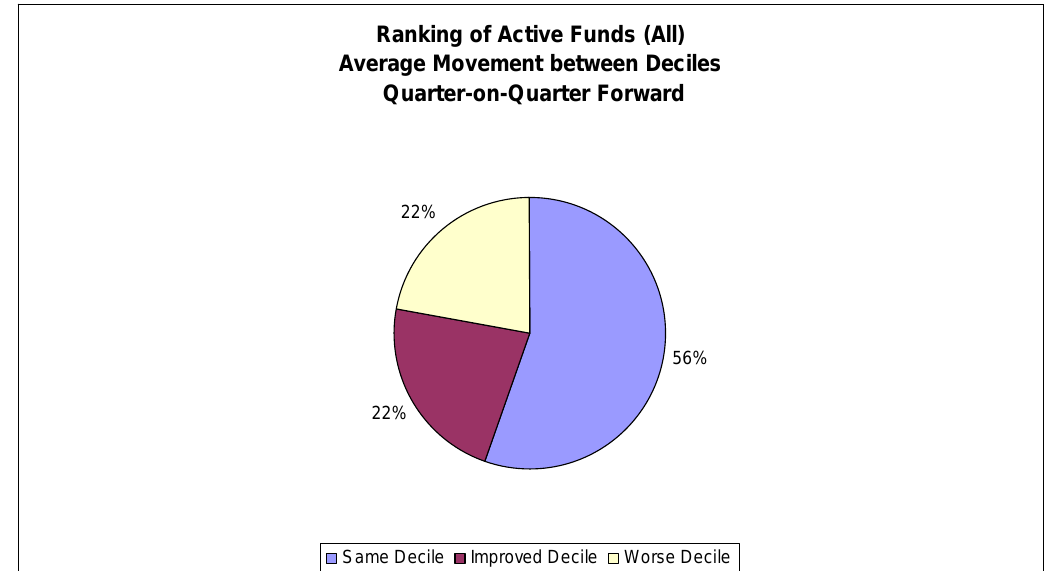
Figure 5: Tendency of actively managed funds to move between deciles on a quarterly